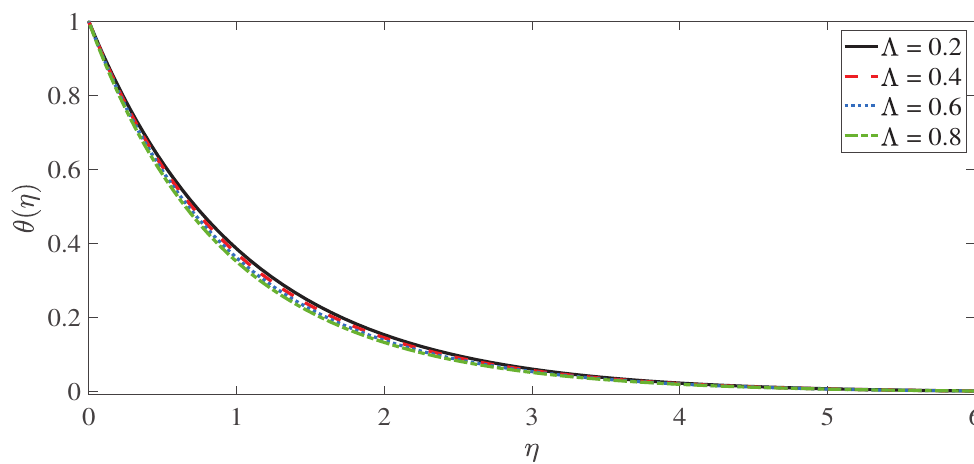
Figure 10. Temperature profile for mixed convection parameter Λ .